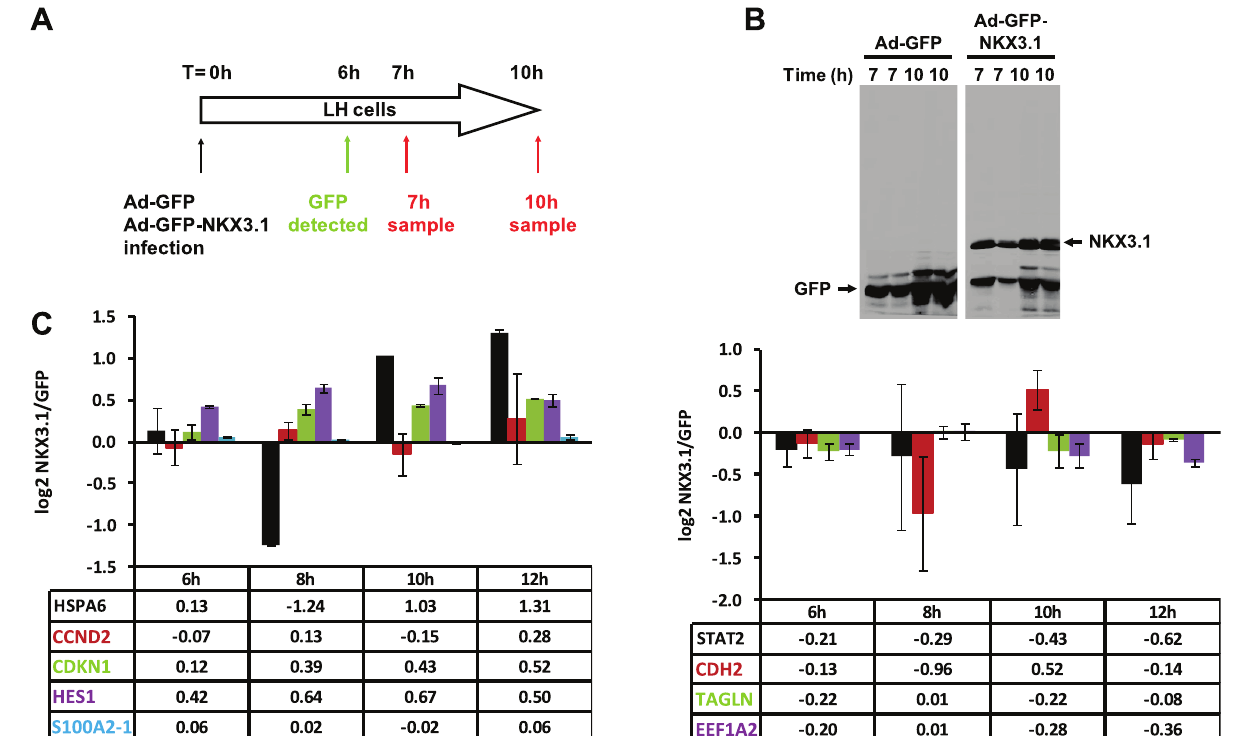
Figure 3. Adenovirus-mediated expression of NKX3.1 in LH prostate epithelial cells regulates specific mRNAs. ( A ) Schematic representation of the time course of the experiment. LH cells were infected in duplicate with adenoviruses driving the expression of